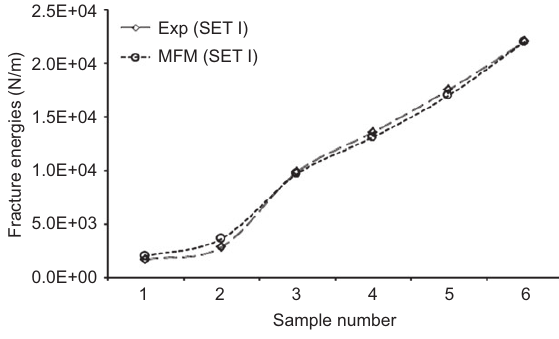
Figure 8 Comparison of the experimental and FL results according to the sample numbers (SET III).